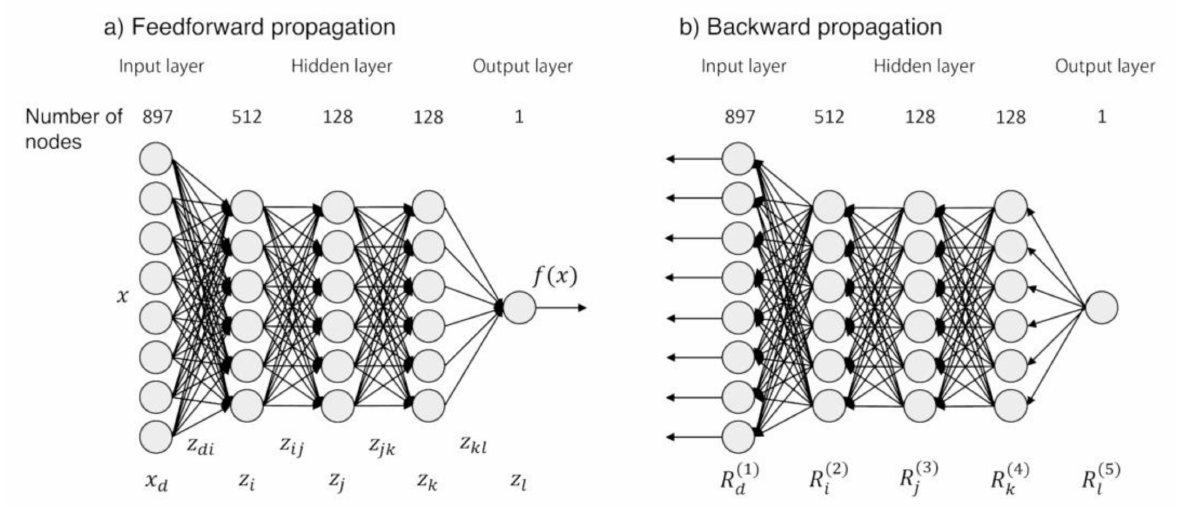
Figure A1. Feedforward propagation ( a ) and back propagation ( b ) for an MLP model with a one-year precipitation time